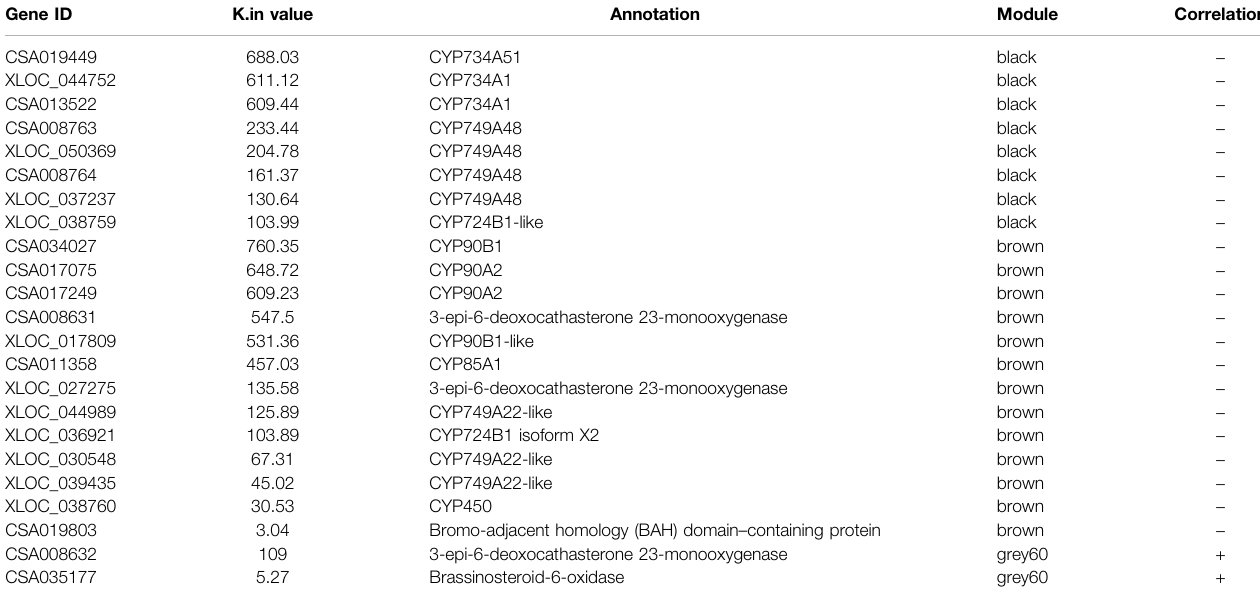
TABLE 2 | List of genes with high expression and the K.in value in ko00905. Gene ID K.in